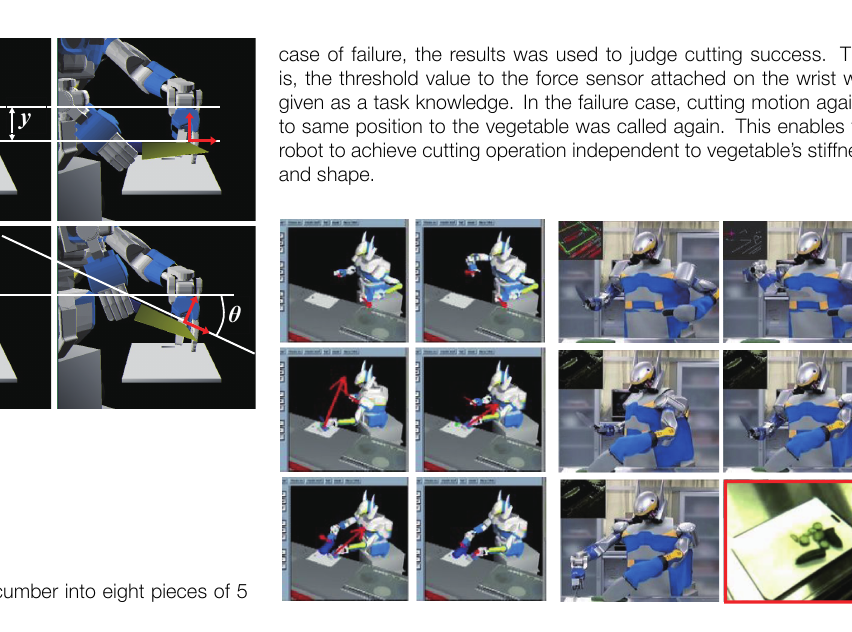
Figure 6. Task Knowledge which are given in each experiments